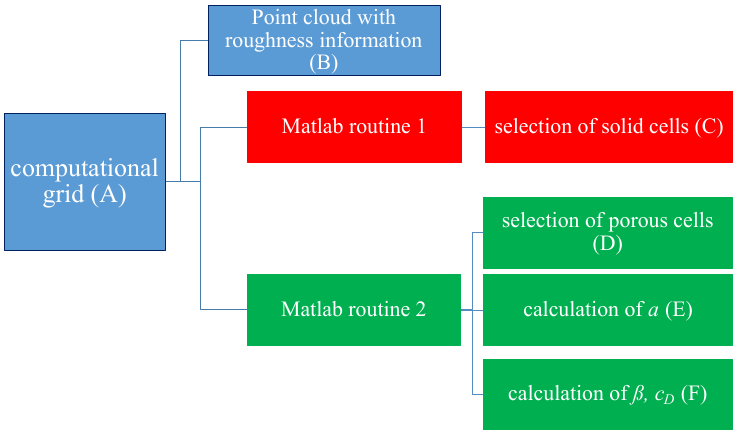
Figure 11. Implementation of the DPM (first step) in